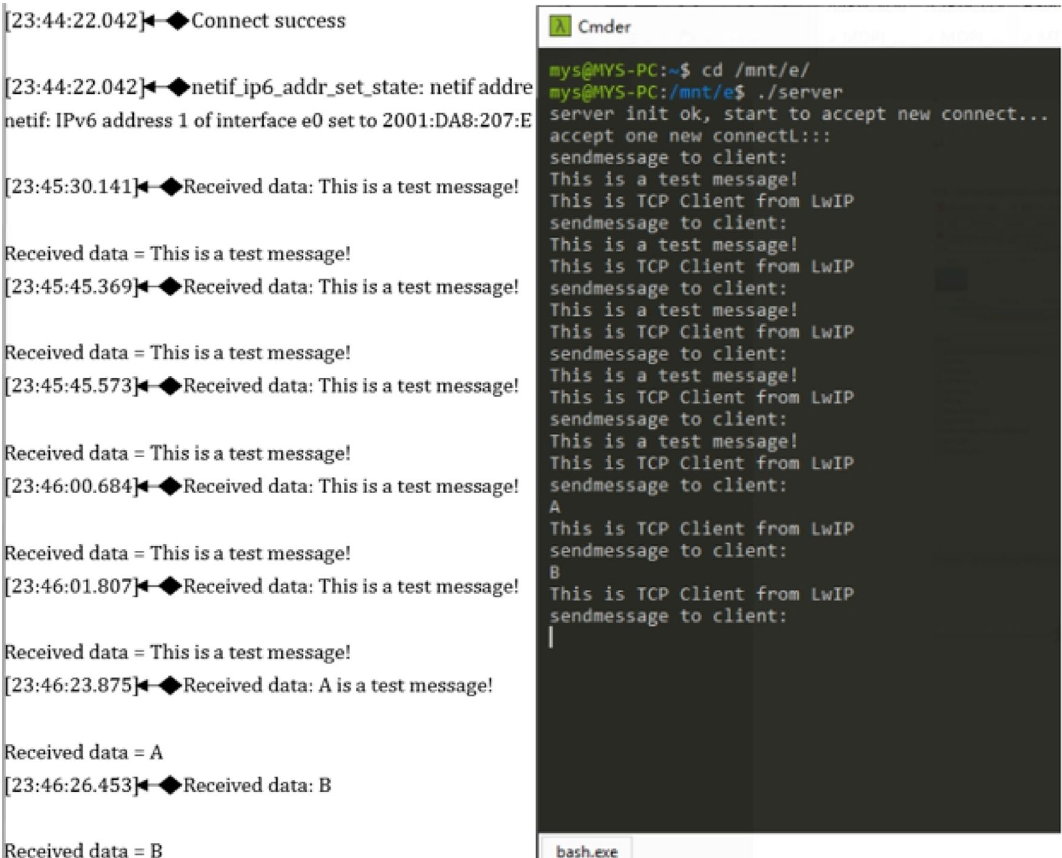
Figure 14. Test information from socket programming communication based on